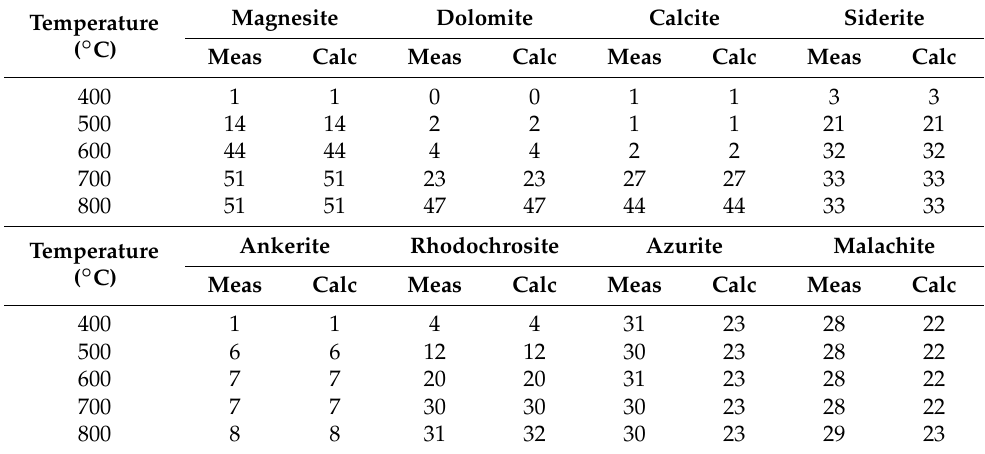
Table 3. Measured weight loss and weight loss calculated from the CO 2 emissions (wt%) for single- mineral carbonates. Meas—measured;